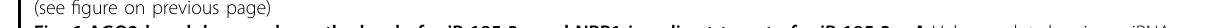
CRC cells upon AGO2 knockdown ( B ) or overexpression ( C ). D Western blotting analysis of NRP1 in CRC cells treated with miR-185-3p inhibitor or its negative control. E Western blotting analysis of NRP1 in SW1116-shAGO2#1 and RKO-shAGO2#1 cells treated with miR-185-3p mimic or its negative control. F Pearson correlation analysis between miR-185-3p and NRP1 in CRC tumor tissues. G Schematic of the miR-185-3p binding site in the 3 ′ UTR of NRP1 mRNA and the corresponding mutation. H , I Luciferase reporter plasmids (NRP1-WT and NRP1-Mut) were co-transfected into 293T cells with miR-185-3p mimic ( H ), miR-185-3p inhibitor ( I ) or the corresponding negative control. Luciferase activity was measured after 48 h. J , K Statistical analyses showing that migration ( J ) and invasion ( K ) were rescued by the miR-185-3p mimic. L Diagram of impaired AGO2/miR-185-3p/NRP1